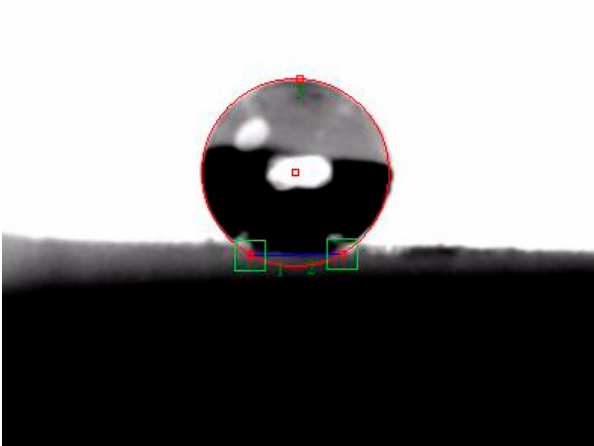
Figure 4. The water contact angle on the surface of aerogel porous board.